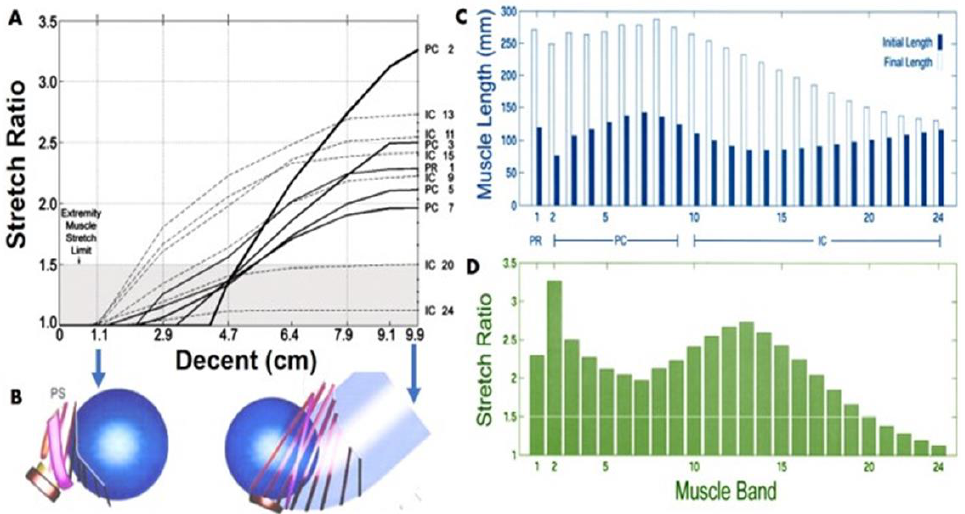
Figure 1. ( A ) The relationship between muscle stretch ratios in selected LAM, PC, IC and PR muscle bands and ( B ) foetal head descent in the birth canal. The shaded region denotes the values of stretch tolerated by non-pregnant appendicular striated muscle without injury. ( C ) Initial and final muscle length. ( D ) Maximum corresponding stretch ratio of each LAM muscle corresponding to foetal head descent. Reproduced with permission of [26]. Copyright NIH Public Access, 2005.